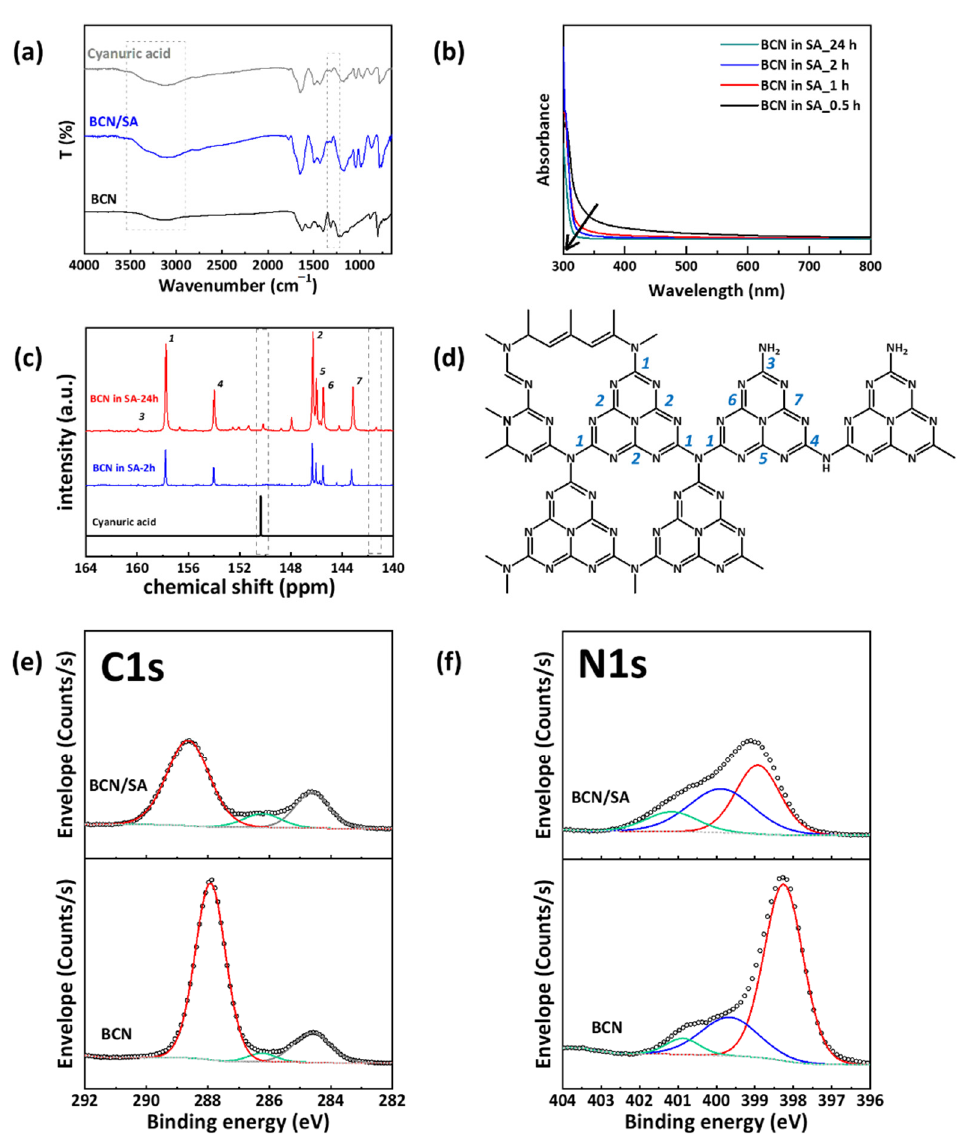
Figure 2. ( a ) Fourier-transform infrared (FT-IR) spectroscopy of BCN and bulk g-CN/surfuric acid (BCN/SA) (cyanuric acid (CA) is inserted for the comparison), ( b ) solution UV/Vis absorption spectroscopy, ( c ) liquid-state 13 C nuclear magnetic resonance (NMR) spectroscopy of BCN dissolved in SA with the increasing time, and ( d ) schematic description of graphitic carbon nitride structure for assignment of carbon species, high-resolution ( e ) C 1s, ( f ) N 1s X-ray photoelectron spectroscopy (XPS) of BCN and